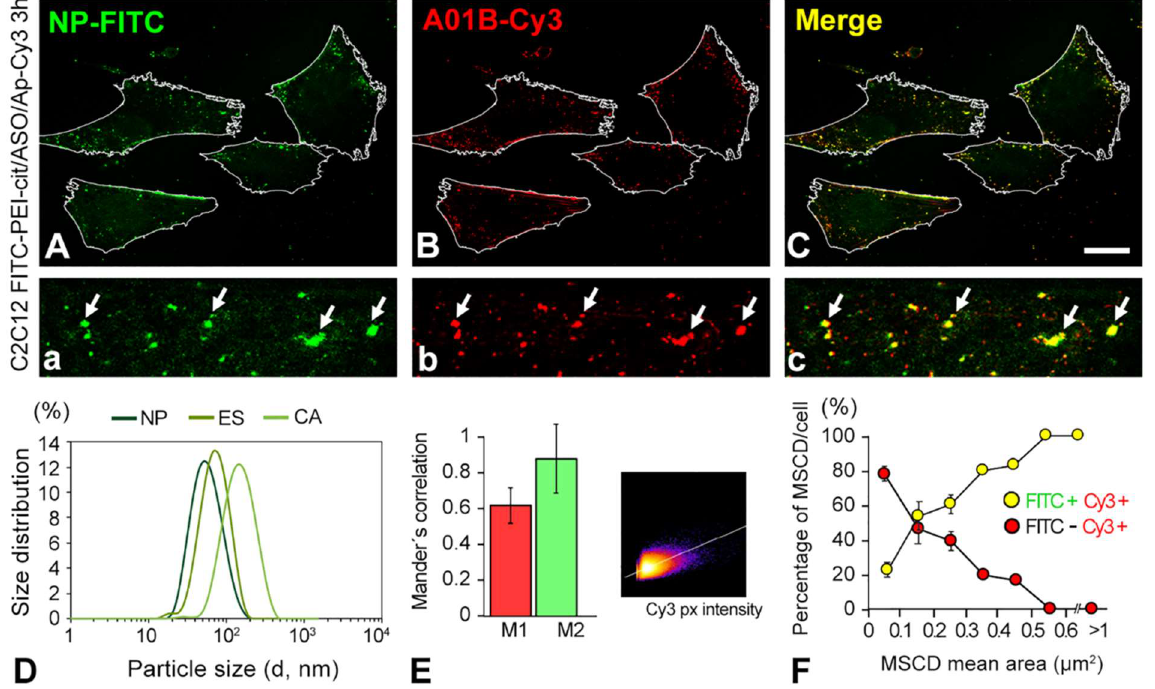
Figure 2. ( A – C ) Confocal microscopy images of C2C12 cells transfected with the FITC-PEI- cit/ASO/Ap-Cy3 nanocomplexes. Images show the colocalization from the PEI green (FITC) signal ( A ) and the aptamer (Ap) red signal (Cy3) ( B ), as well as ( C ) the overlap of both channels within the